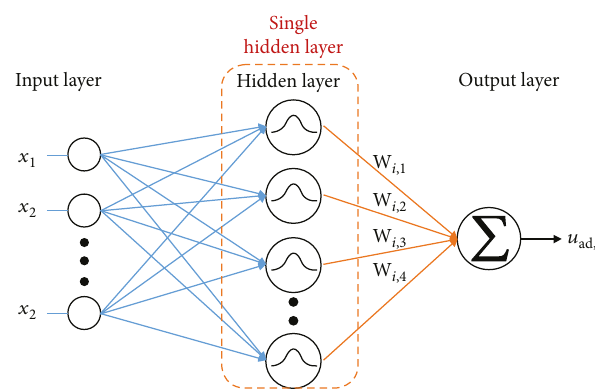
Figure 4: Schematic of the radial basis function neural